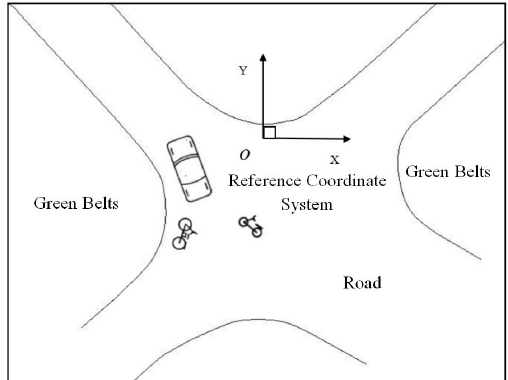
Figure 3. Establishing the coordinate